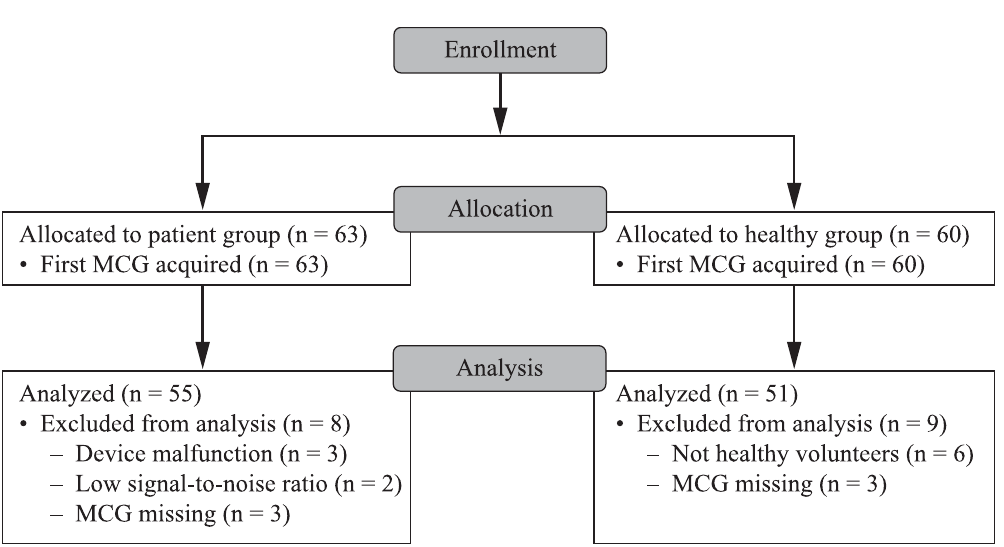
Fig 1. CONSORT Diagram: Technical performance study. Participant flow through the technical performance study. Data were analyzed for 55/63 patients and 51/60 healthy controls.